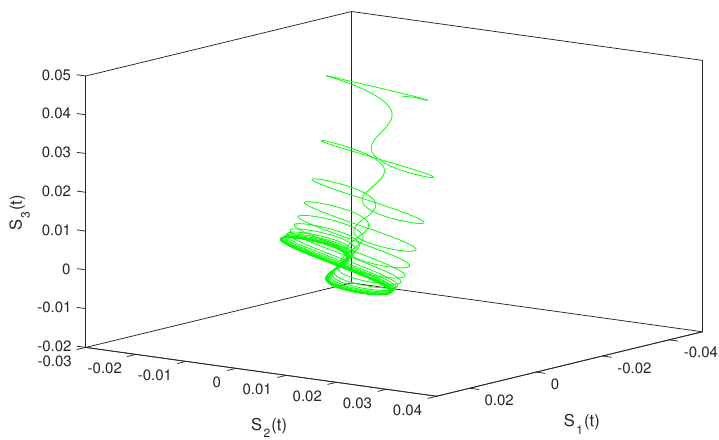
Figure 4. Continuous situation T = R : x 1 ( t ) , x 2 ( t ) , x 3 ( t ) .